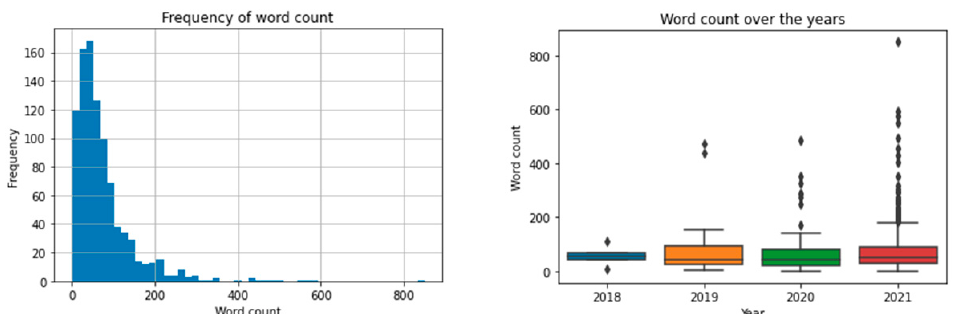
Figure 1. Histogram presenting the frequency of word counts per post ( left ). Word count was subdivided over the year in which a post was written to evaluate the trend in word count over years ( right ).